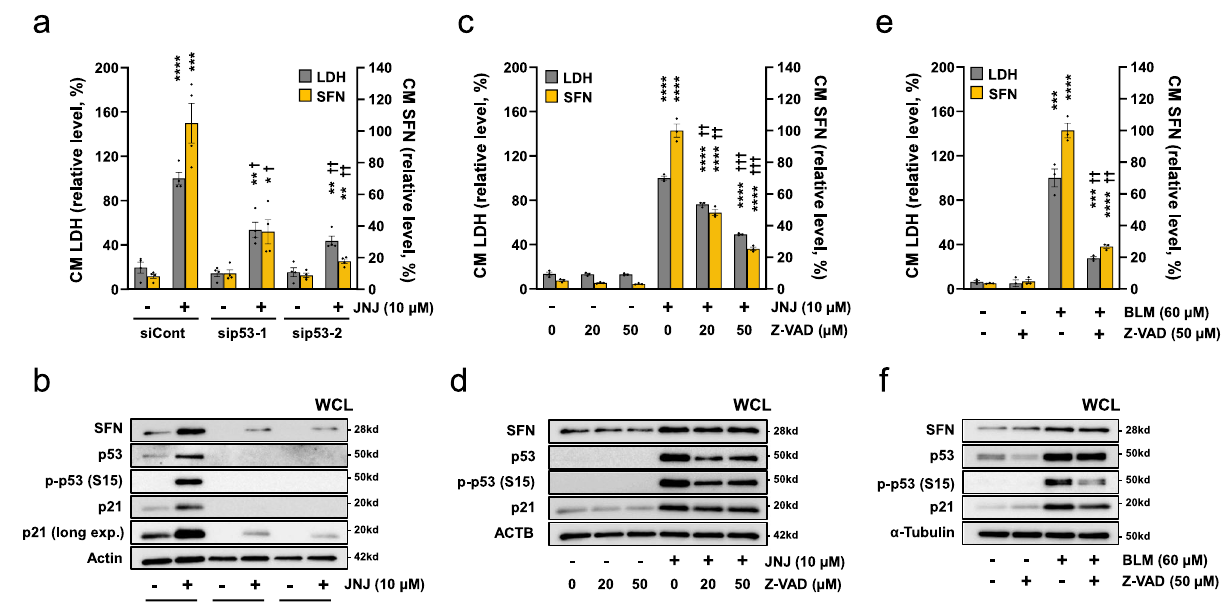
Fig. 7 | Extracellular release of SFN via p53-dependent apoptosis. a , b Effect of p53 knockdown on the release/expression of SFN. Twenty-four hours after trans- fection of A549 with control (siCont) or anti-p53 siRNAs (sip53-1, or − 2), the cells were treated with JNJ (10 μ M) for 48h. The graph presented mean values±SEM of n =4 biologically independent experiments. c , d Effect of caspase inhibitor on release/expression of SFN. After treatment with the indicated concentrations of Z- VAD-FMK for 30min, A549 cells were incubated with JNJ (10 μ M) for 48h. The graphpresentedmeanvalues±SEMof n =3biologicallyindependentexperiments. e , f The release/expression of SFN in the primary cultured small airway epithelial cells (SMECs). After treatment with or without Z-VAD-FMK (50 μ M) for 30min,